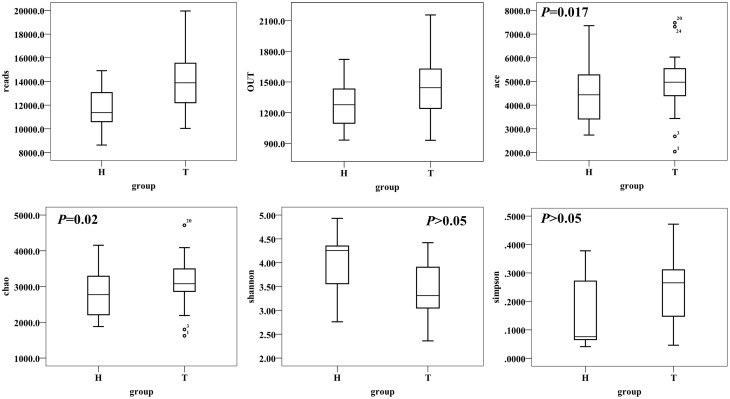
Alpha-diversity distances calculated using phylotype relative abundance measurements between healthy and CRC groups demonstrate that the microbial richness of CRC patients is higher than healthy individuals, while the diversity has no statistical significance between two groups.